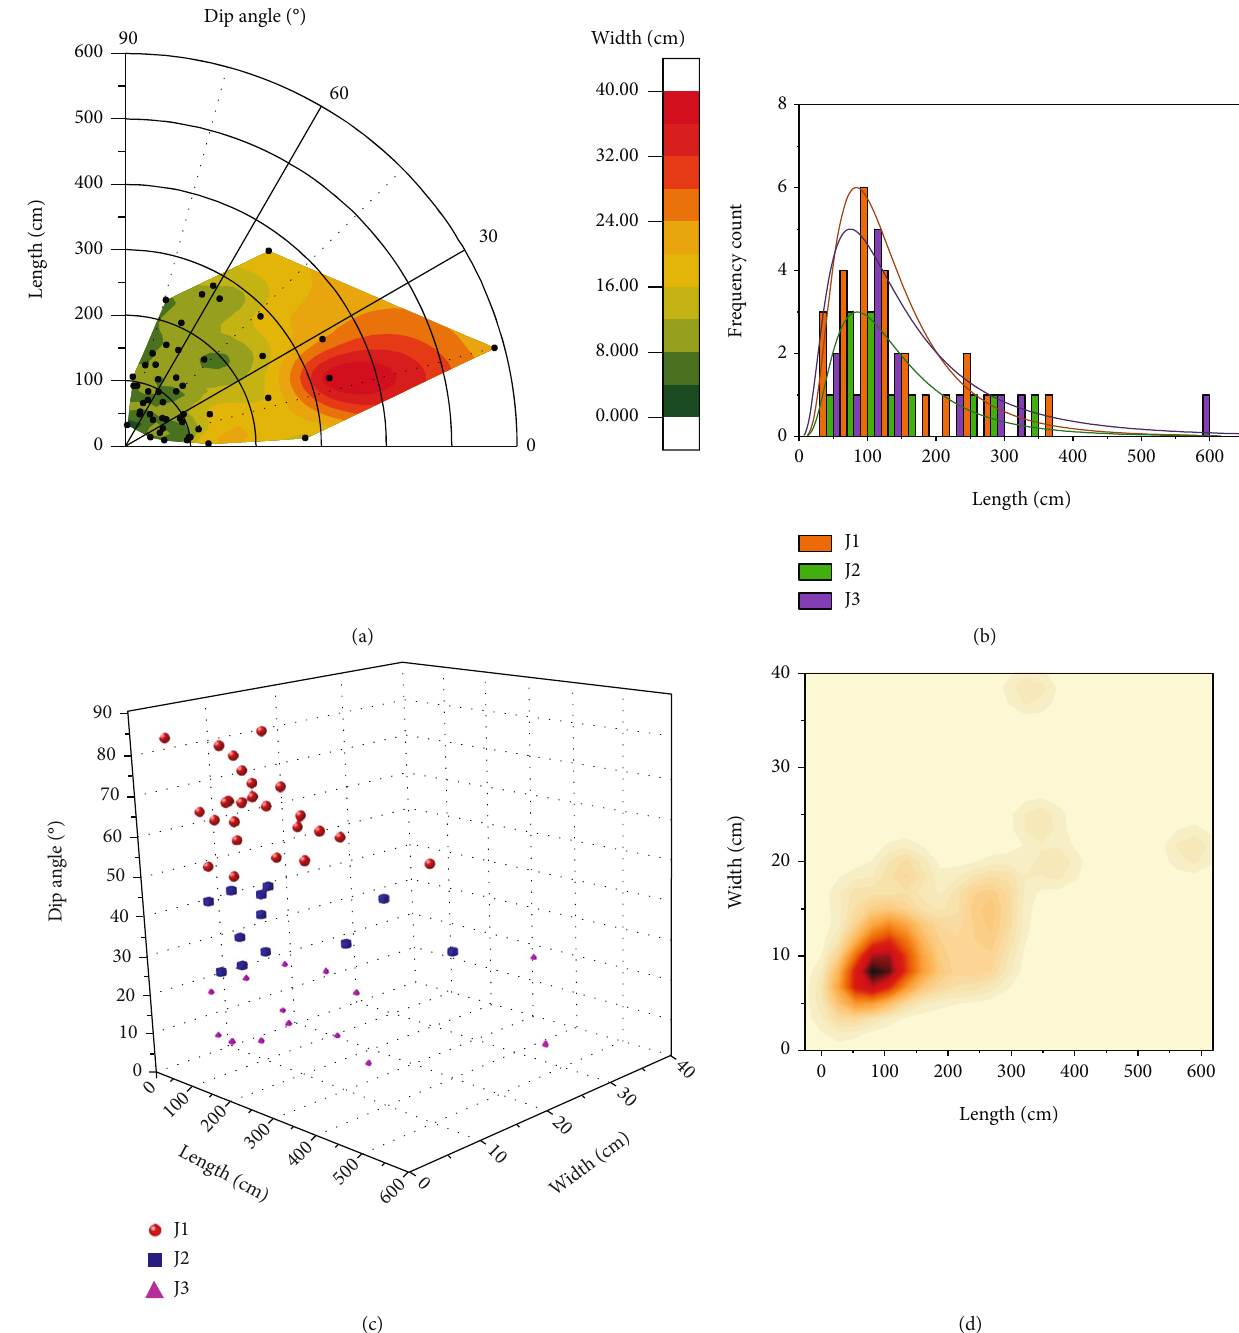
Figure 23: Statistical parameters of the linear discontinuities. (a) Dip angle contour plot considering length and width. (b) Frequency count of 3 sets of linear discontinuities. (c) Clustering plot of 3 sets of linear discontinuities. (d) Geometrical size distribution of